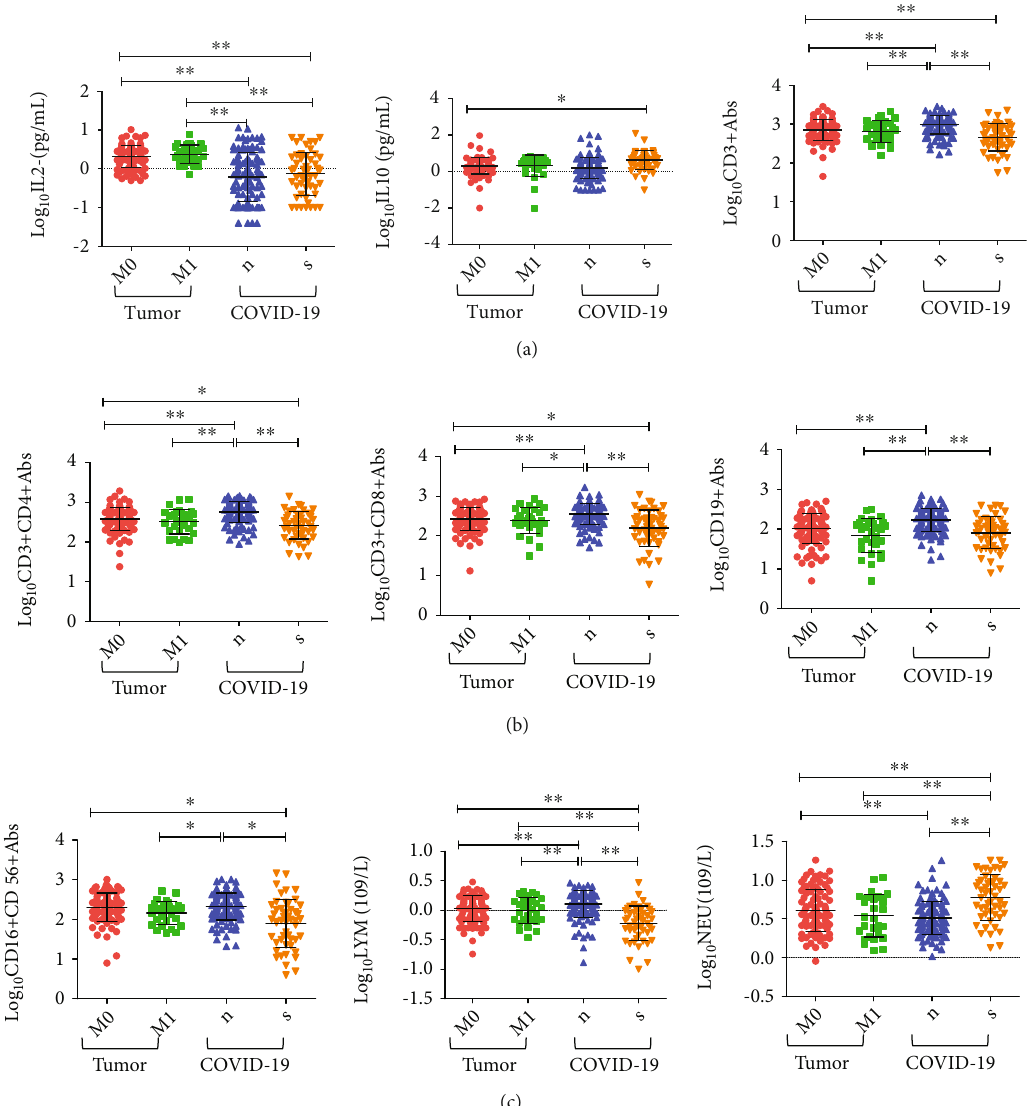
Figure 1: Analysis of immune cells and cytokines in the four subgroups of patients with COVID-19 or cancer. n : nonsevere; s : severe. (a) IL- 2 (left), IL-10 (middle), and CD3 + Abs (right). (b) CD3 + CD4 + Abs (left), CD3 + CD8 + Abs (middle), and CD19 + Abs (right). (c) CD16 + CD56 + Abs (left), LYM (middle), and NEU